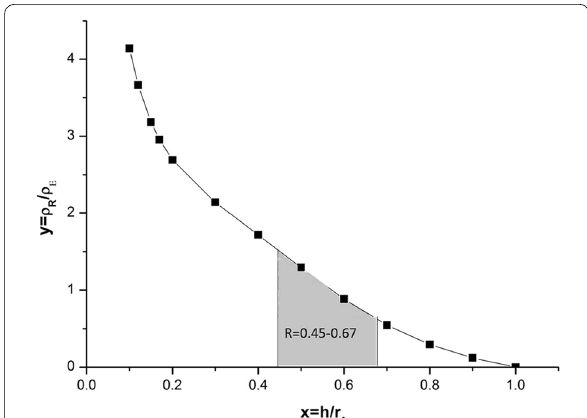
Fig. 16 Normalized curvature (y) versus penetration depth ratio (x).